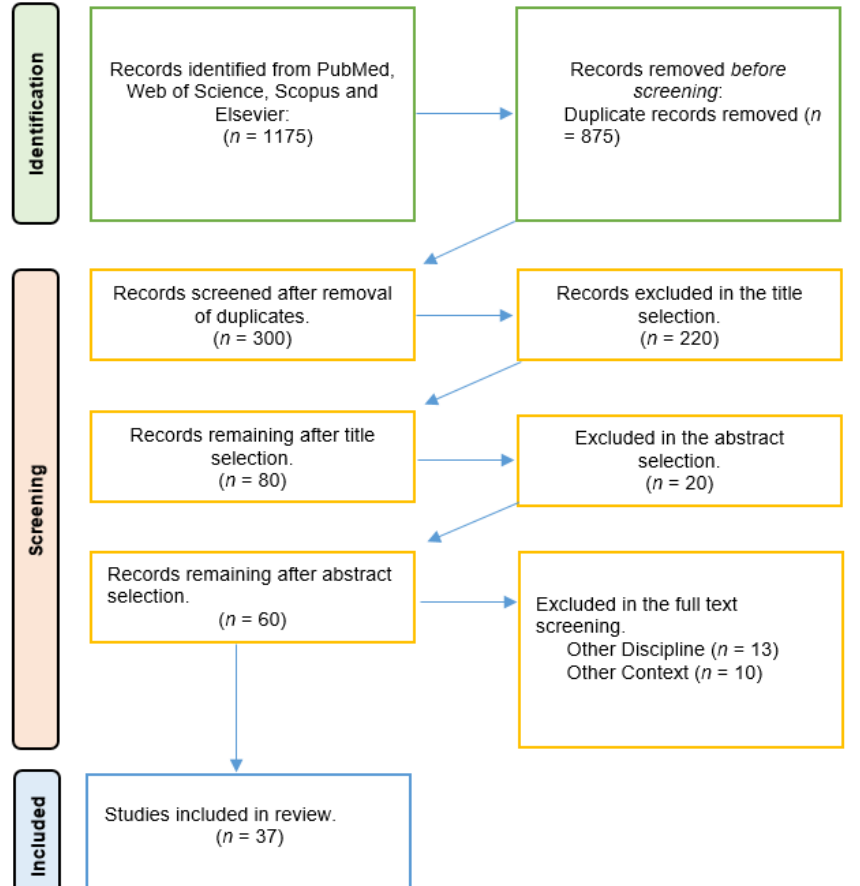
Figure 1. Flow chart of the selection process of the included studies.